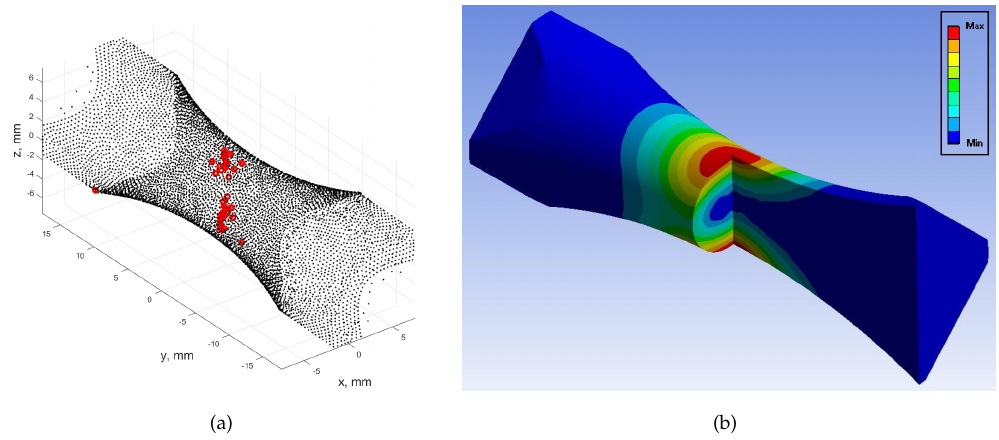
Figure 18. ( a ) Distribution of the most stressed mesh nodes calculated according to the von Mises criterion for in-phase kinematic loading; ( b ) Area of occurrence of plastic strains finite element method (FEM) calculated for the Chaboche cyclic plasticity model for in-phase kinematic loading.